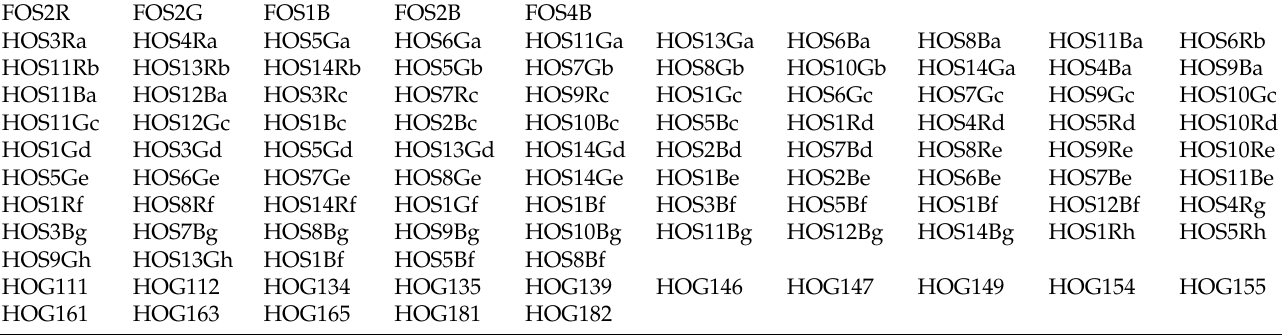
Table 3. A listing of the 105 features selected by GA from the original 429 features (See Section 4 for feature codes). FOS2R FOS2G